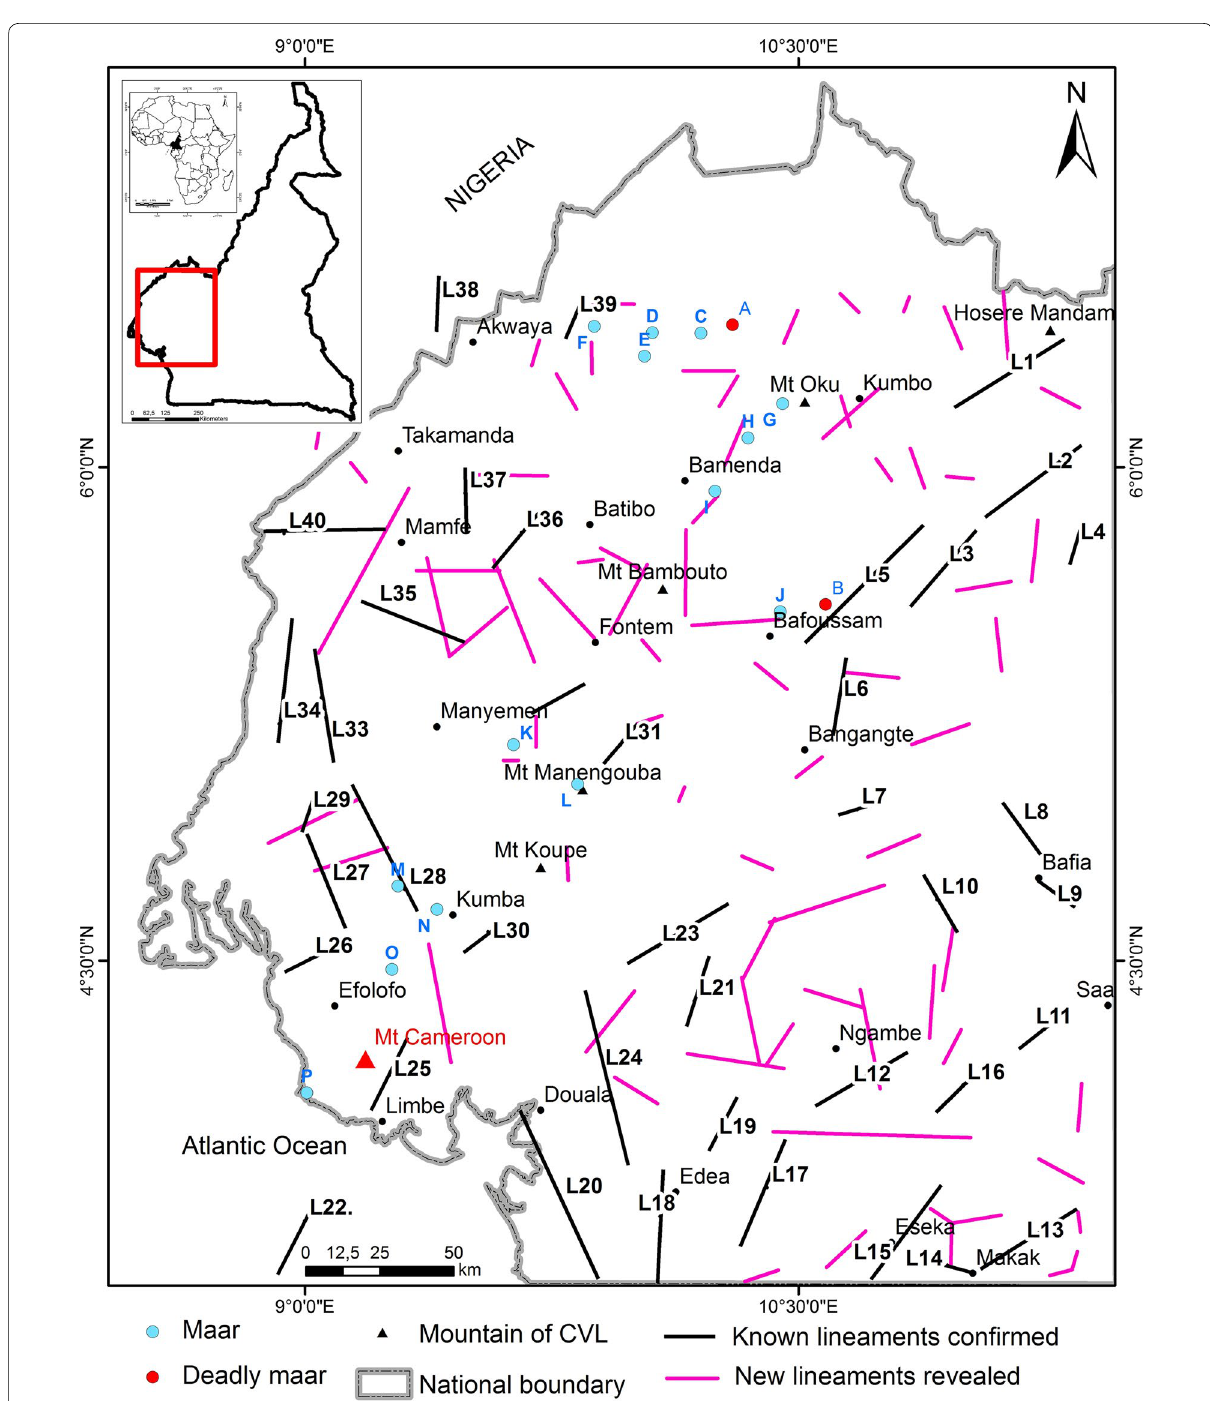
Fig. 10 Lineaments extracted from gravity data derived from EGM2008. Maars of study area ( A Nyos maars, B Monoun, C Mbulom, D Wum maar, E Mbellifang maar, F Benakuma, G Oku maar, H Sabga maar, I Bambili maar, J Baleng, K Beme, L Manengouba maar, M Bikoki maar, N Barombi maar, O Barombi Koto maar, P Debunscha) The deadly maar lakes and Mount Cameroon are highlighted in